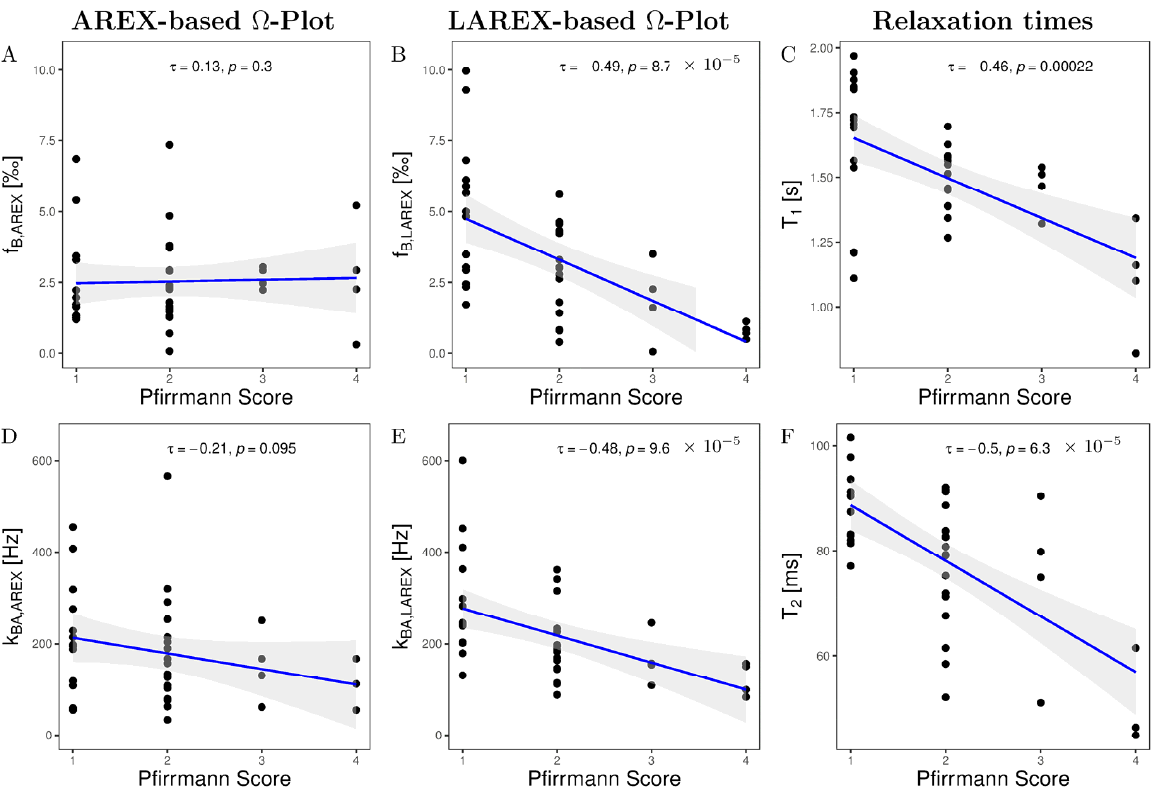
Figure 3. Kendall-Tau correlations of altered fractional GAG concentrations f b ( A , B ), GAG exchange rates k ba ( D , F ), T 1 - ( C ), and T 2 relaxation times ( F ) as a function of Pfirrmann scoring in our measured in vivo IVDs and the two methods examined, the AREX-based Ω -plot and the LAREX-based Ω -plot. In all correlation plots, a black dot corresponds to the mean value of the studied parameter for a single IVD and the gray background illustrates the 95% confidence interval of the correlation. ( A ) AREX-based fractional concentrations show a non-significant and negligible decrease with Pfir- rmann scoring. ( B ) The LAREX-based determination of fractional GAG concentrations shows a moderate and significant decrease as a function of Pfirrmann scoring. ( C ) T 1 relaxation times shows a moderate and significant decrease with Pfirrmann scoring. ( D ) The AREX-based exchange rate determination shows a small and non-significant increase as a function of Pfirrmann scoring. ( E ) With Pfirrmann scoring, the LAREX-based exchange rate shows a moderate and significant reduction. ( F ) T 2 relaxation times shows a moderate and significant decrease with Pfirrmann